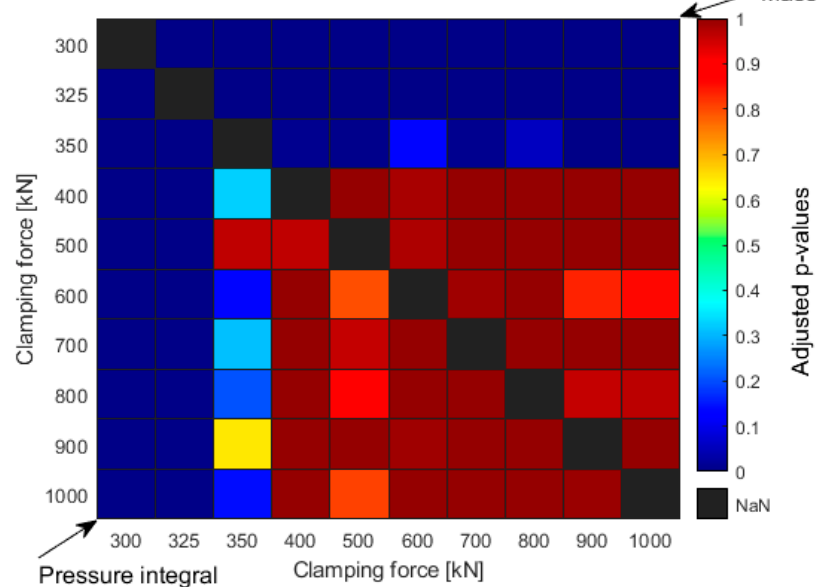
Figure 4. The adjusted p -values (from the Tukey–Kramer post hoc test) for each clamping force pair for the pressure integrals (below the diagonal) and part weights values (above the diagonal).